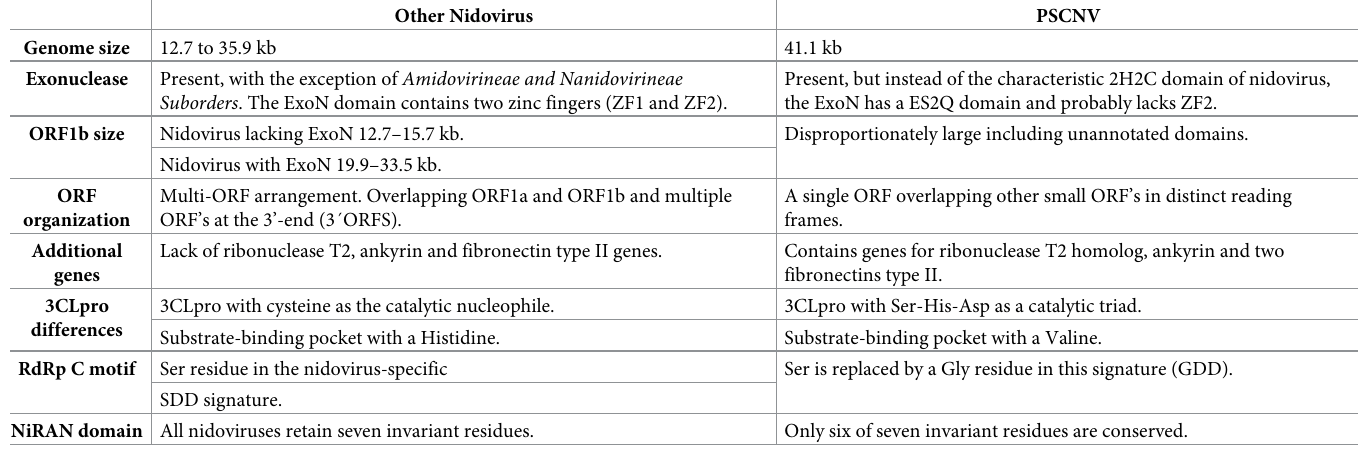
Table 2. Differences between PSCNV and other nidoviruses, based on Saberi et al., 2018 [14]. Other